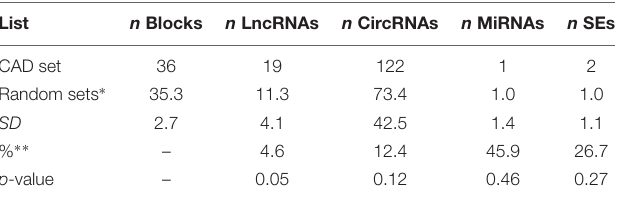
TABLE 2 | Results of the analysis performed on the CAD-associated loci (upper part) and on 1,000 random sets (lower part). List